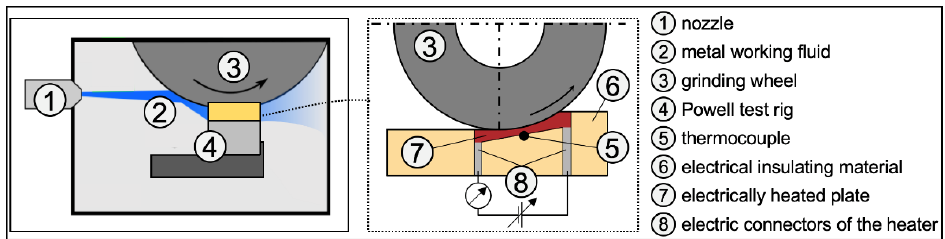
Figure 5. Setup for the evaluation of the cooling effect of the MWF supply.